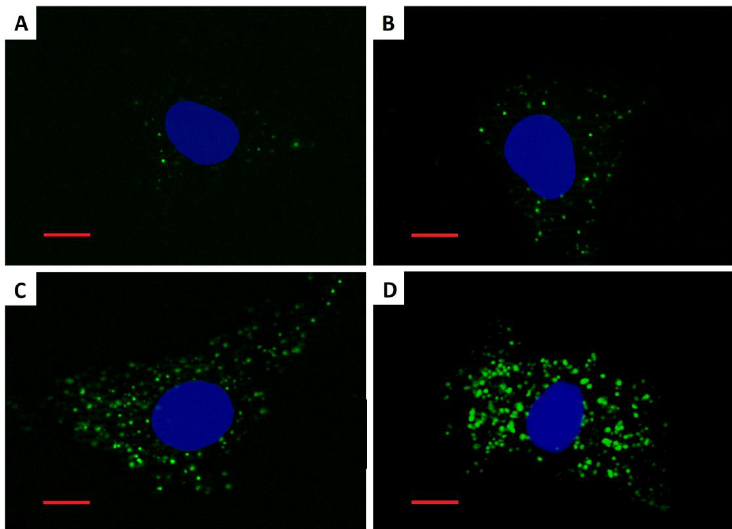
Figure 4. Fluorescence images of A549 cells stained by the LipidTOX dye after a 48-h incubation. ( A ) Untreated control cell; ( B ) cell treated with 20 µ g · mL − 1 γ -Fe 2 O 3 + SiO 2 -COOH; ( C ) cell treated with 20 µ g · mL − 1 γ -Fe 2 O 3 + SiO 2 -NH 2 ; ( D ) cell treated with 20 µ g · mL − 1 γ -Fe 2 O 3 + SiO 2 . Green fluorescence represents phospholipid rich organelles. Blue fluorescence represents cell nuclei. Scale bar = 10 µ m.